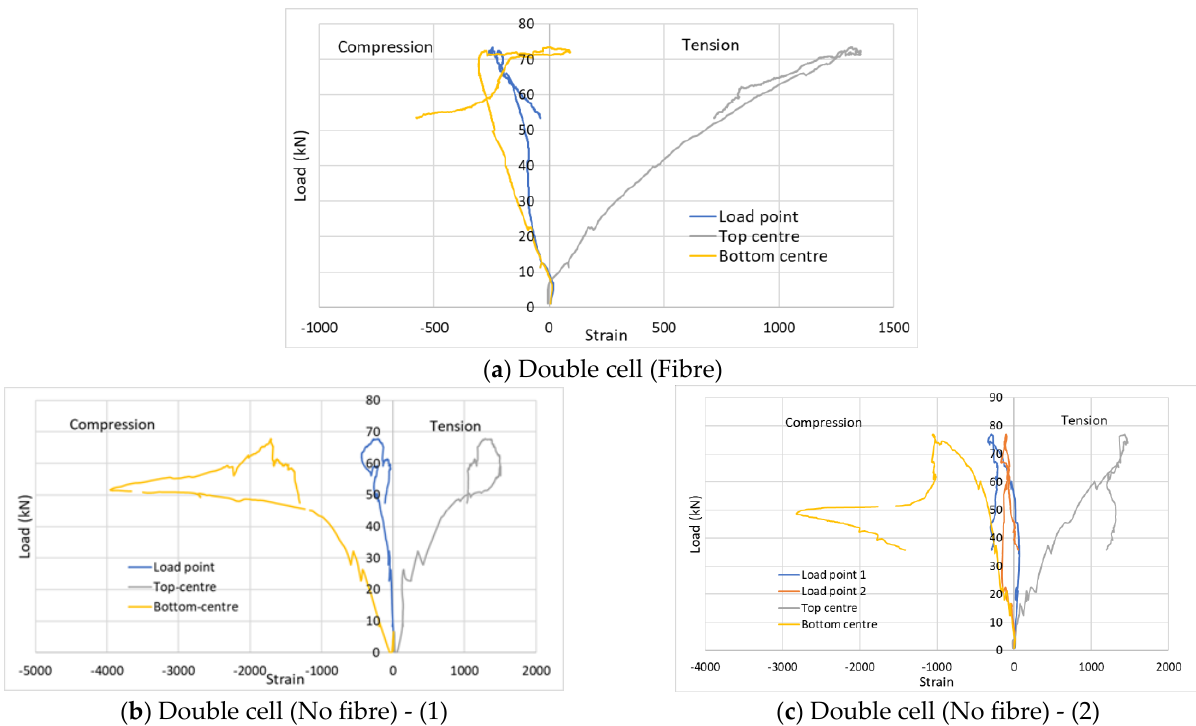
Figure 12. Strain mapping of double-cell